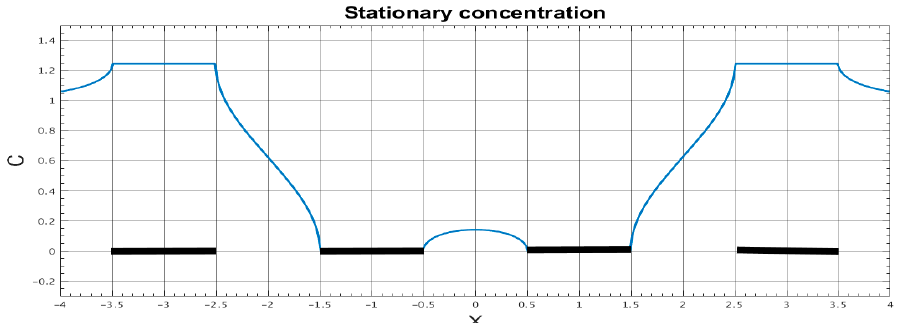
Figure 5. Dimensionless stationary concentration vs. coordinate on the electrochemical cell channel walls. Thick black lines correspond to the electrodes position.